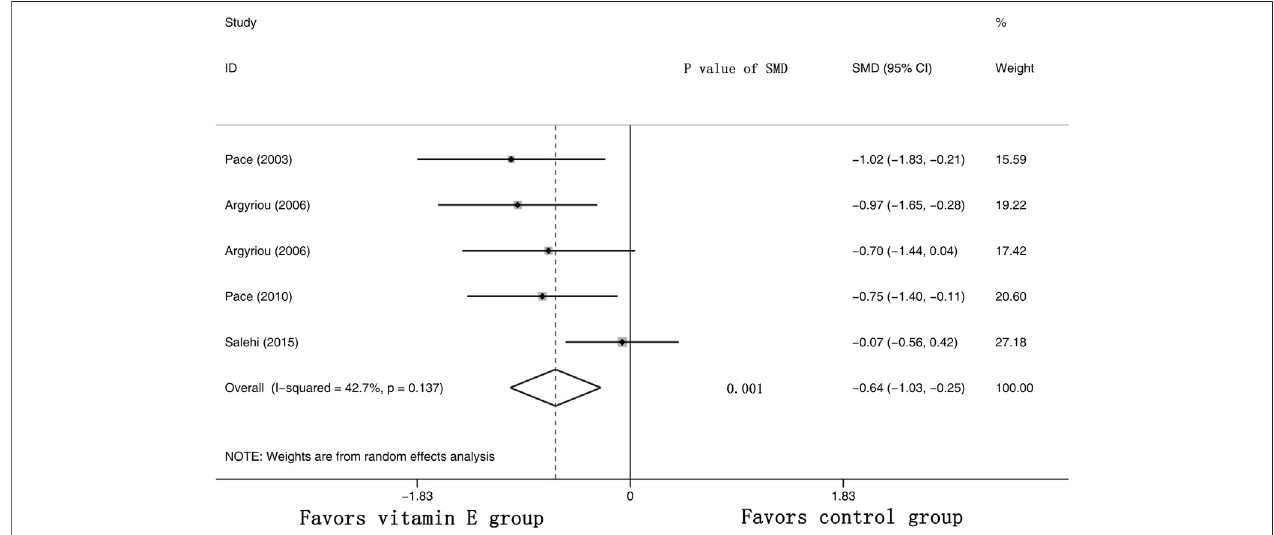
FIGURE 7 | Forest plot of the total neuropathy scores in VE and control groups. Summary of the incidence of the total neuropathy scores SMD between VE and control groups were calculated using the random effect model. VE, vitamin E; CIPN, chemotherapy-induced peripheral neuropathy; SMD, standard mean differences; P, p value of the Q test for heterogeneity.